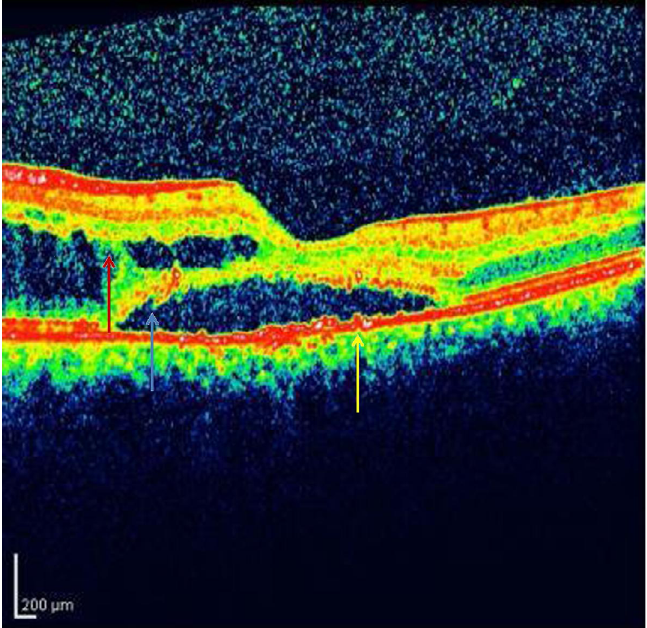
Figure 2: A Spectral OCT image showing pigment epithelial protrusion (yellow arrow), retinal dipping (red arrow) and fibrinous exudate (blue arrow) in ACSC.